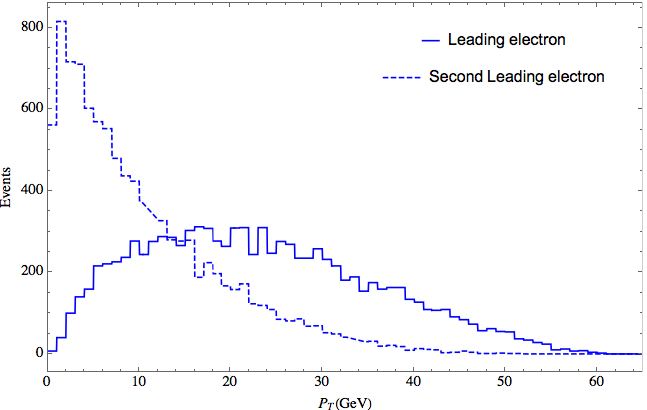
Figure 7 . p T distribution of the two leading electrons for M = 15GeV.